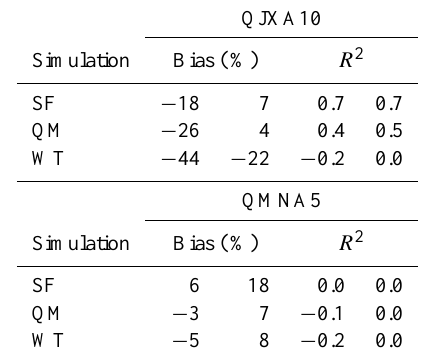
Fig. 11: Difference between the QMNA5 calculated with the two simulations forced by downscaling methods and the simulation forced by SAFRAN/F (in %) for the period 1970-1999.